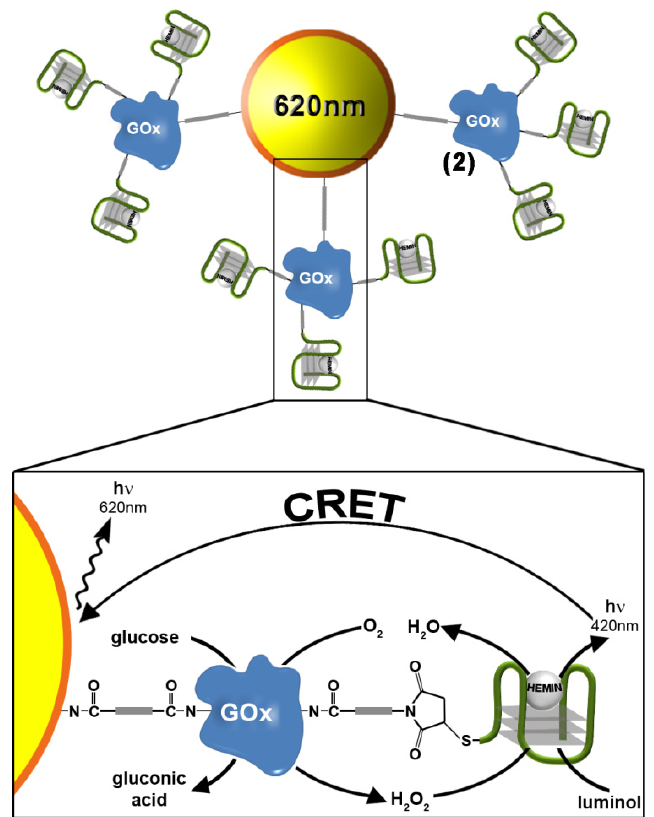
Figure 3. Analysis of glucose by the hemin/G-quadruplex-modified GOx that catalyzes the oxidation of glucose by oxygen and the formation of H generation of chemiluminescence in the presence of luminol/ H process to the